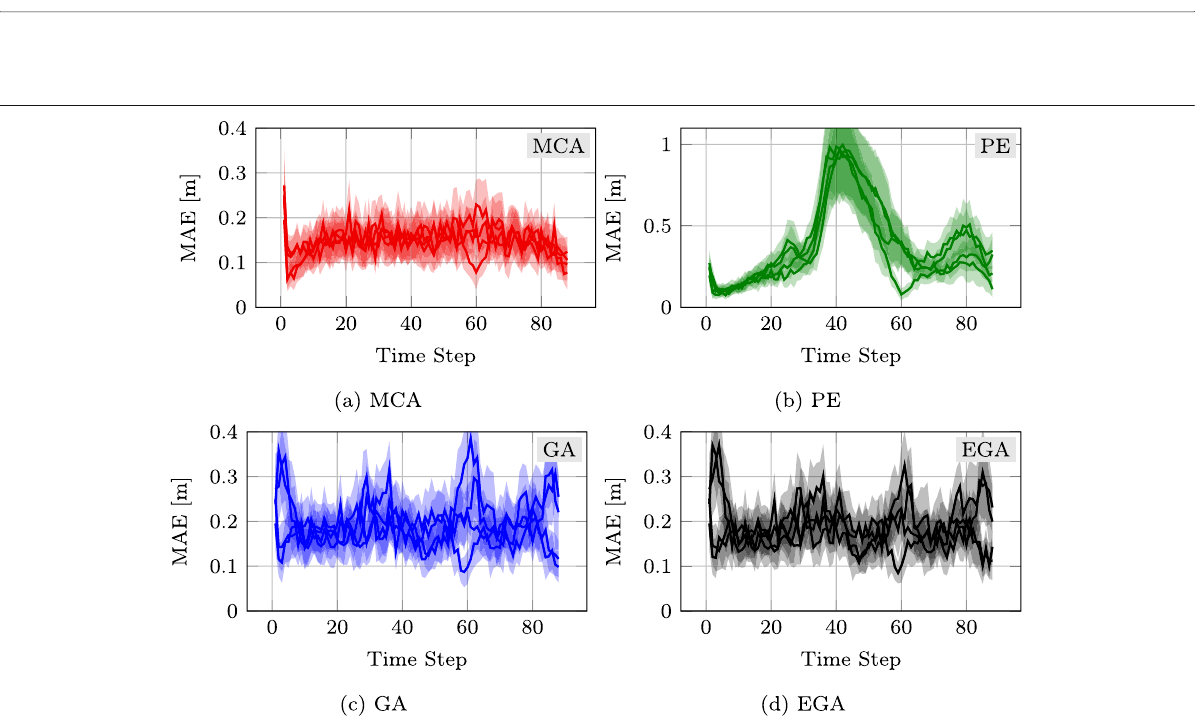
Fig. 7 Localization error as a function of the time step for M = 4 agents in MNS 2. The individual solid lines in each of the plots correspond to one of the agents. The CIs are illustrated as transparent hoses around the mean performance. a MCA. b PE. c GA. d